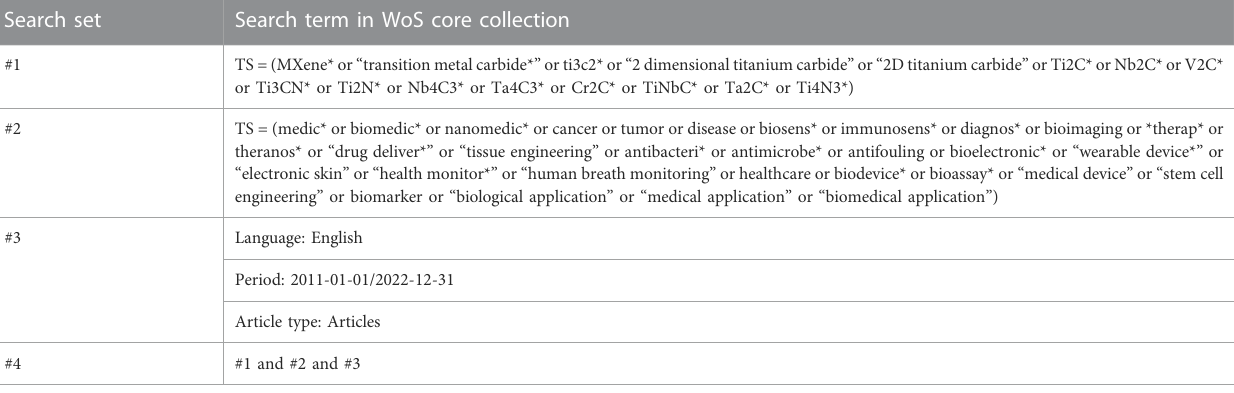
TABLE 1 Employed search